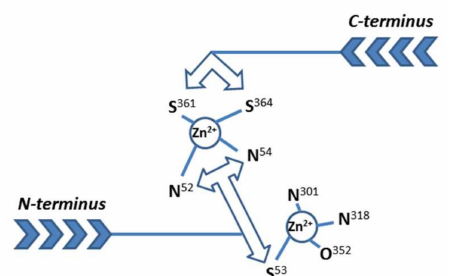
Figure 8. The two Zn 2+ -binding sites in the cytosolic C-terminal domain (CTD) of human ZnT8. The presentation is based on a recent Cryo-EM structure of the entire protein [20]. One metal ion is bound by two N-donors from histidines (301 & 318) and one O-donor from glutamate (352). An S-donor from cysteine (53) from the N-terminus (not present in the CTD) complements a tetrahedral binding geometry. The second site is assembled from donors of the C- and N-termini only: Two S-donors from cysteines (361 & 364) from the C-terminus and two N-donors from histidines (52 & 54) from the N-terminus. The N-terminal tripartite motif with adjacent metal-coordinating amino acid side chains (HCH) “seals off” the metal sites [20]. Both termini have to swing into the site to effect coordination of the second metal